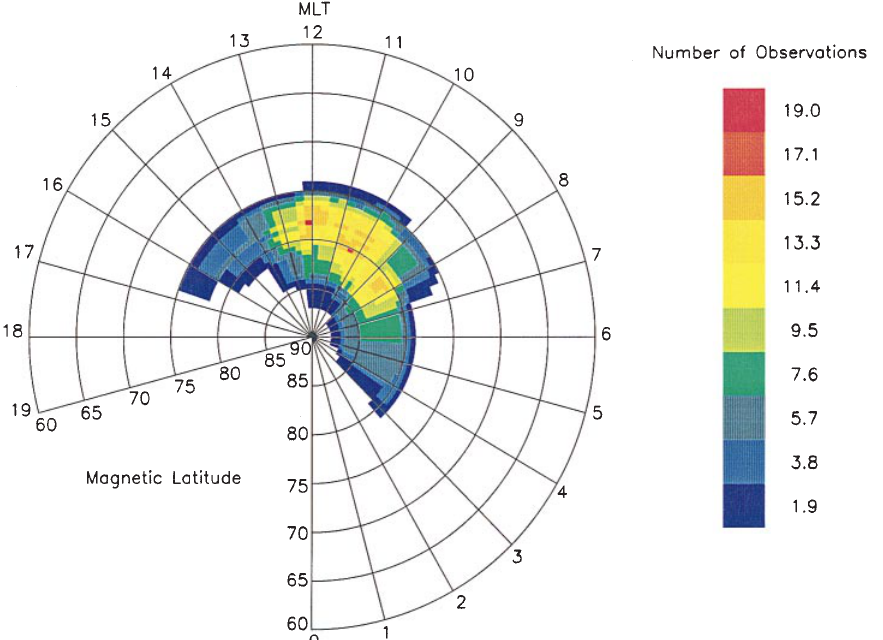
Fig. 3. Occurrence distribution in lati- tude and MLT of pulsed ionospheric flow (PIF) signatures, as observed by the CUTLASS Finland radar from March 1995 to February 1997 when run in high-time